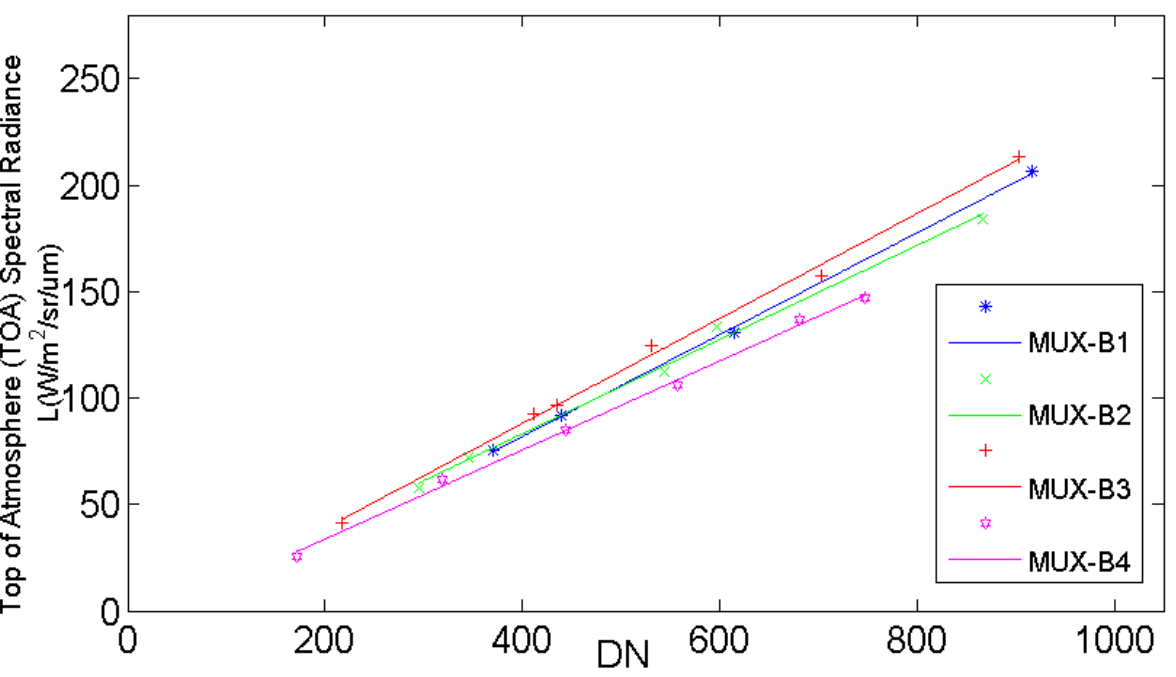
Figure 9. Calibration result of the gray-scale permanent artificial targets (coefficient A).